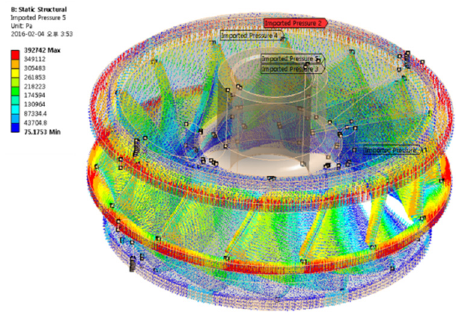
Figure 18. Pressure imported to the runner surfaces.